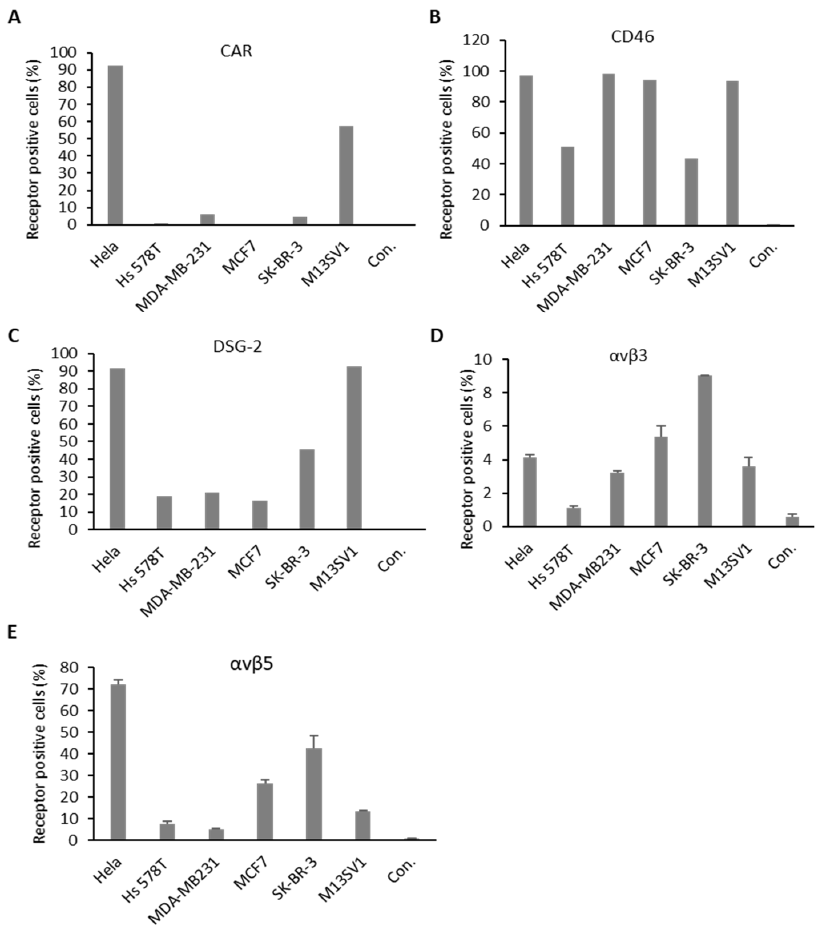
Figure 5. Major adenovirus receptor expression levels on BC cell lines. Cells were stained with antibodies against coxsackievirus and adenovirus receptor (CAR) ( A ), cluster of differentiation 46 (CD46) ( B ), desmoglein-2 receptor (DSG-2) ( C ), and integrins α v β 3 and α v β 5 ( D,E ). Receptor expression was measured via flow cytometry, expressed as percentage of CAR, CD46, DSG-2, and integrin-receptor-positive cells. Hela cells were used as positive control. Unlabeled cells (negative controls) were used to set the background gate below 1%. A total of 10,000 viable cells were counted.